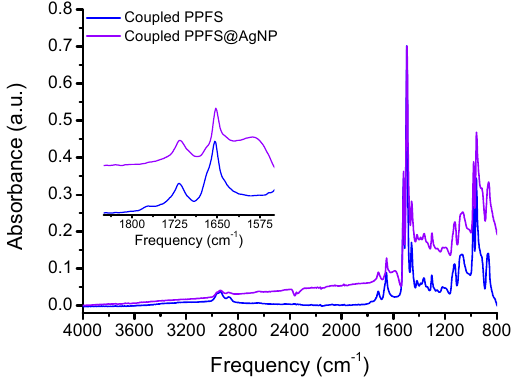
Figure 2. Attenuated Total Reflectance Fourier Transform Infrared (ATR-FTIR) analysis of coupled PPFS and anchored PPFS@AgNPs.